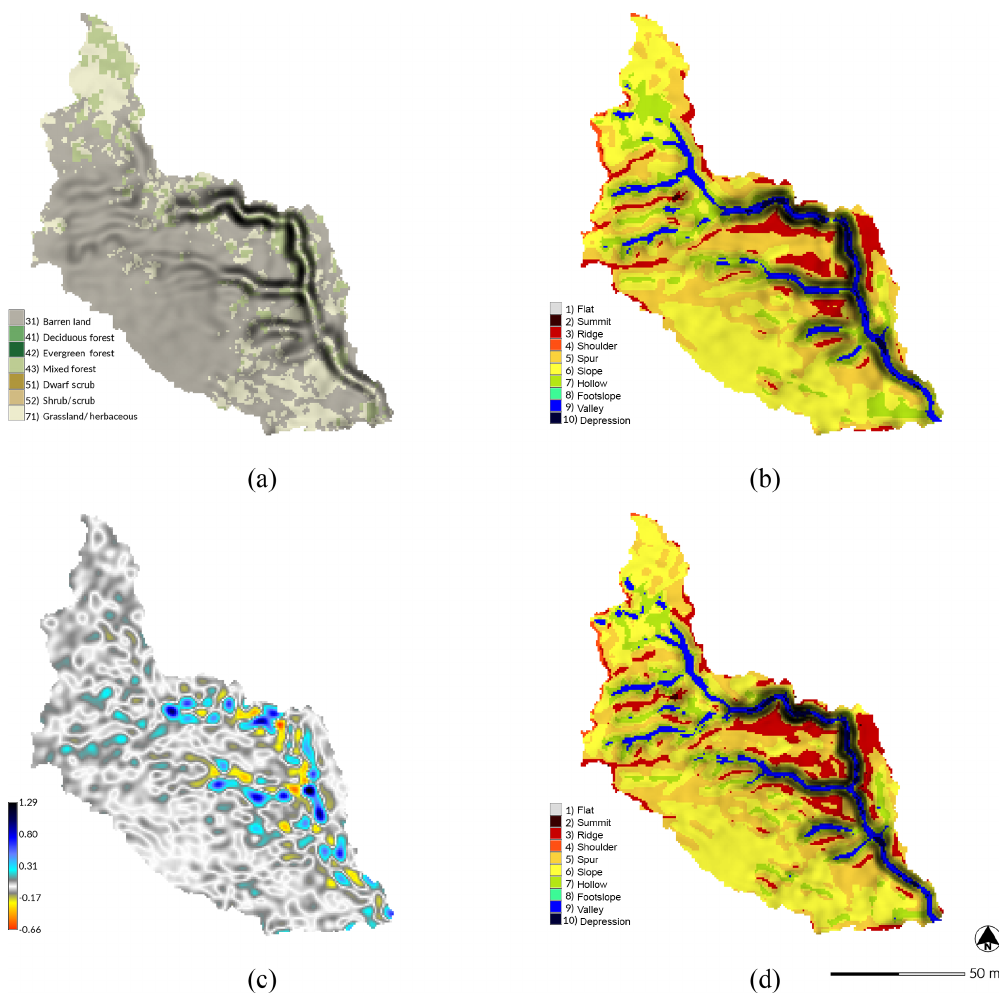
Figure 6. Detailed morphological change for drainage area 1 of Patterson Branch, Fort Bragg, NC, USA: (a) land cover in 2014, (b) landforms in 2012, (c) elevation difference between 2012 and 2016 [m], and (d) landforms in